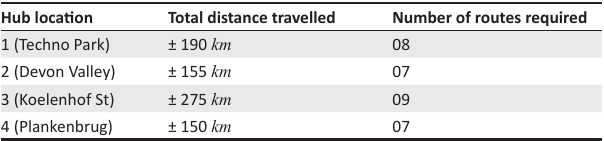
TABLE 2: Distances travelled. Hub location Total distance travelled Number of routes